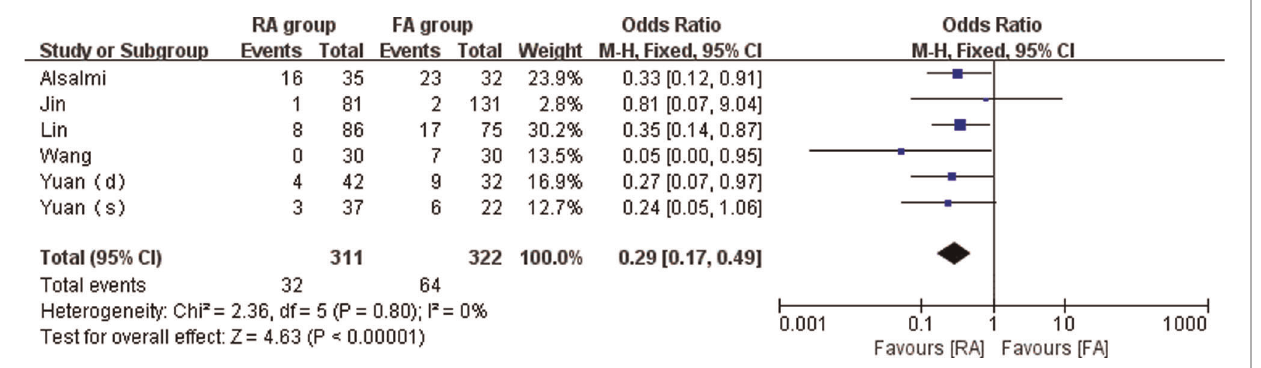
FIGURE 5 | Forest plot depicting the OR of the cement leakage